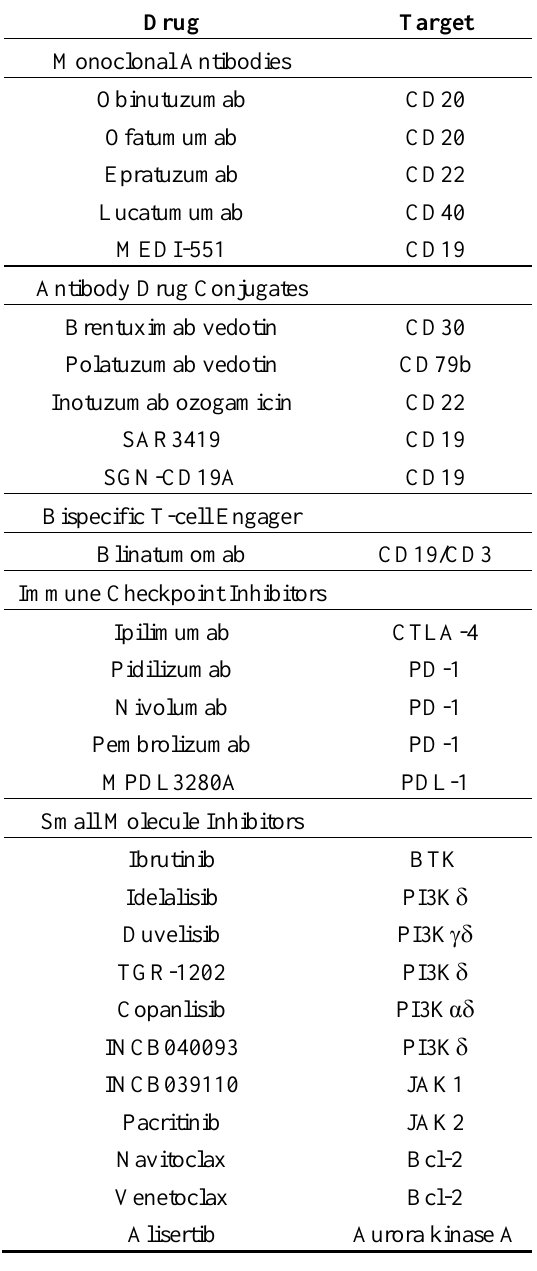
Table 1. Overview of novel agents discussed in this review and their